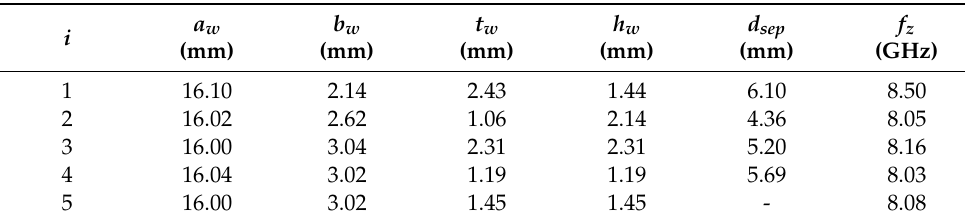
Table 1. Rx band filter dimensions.